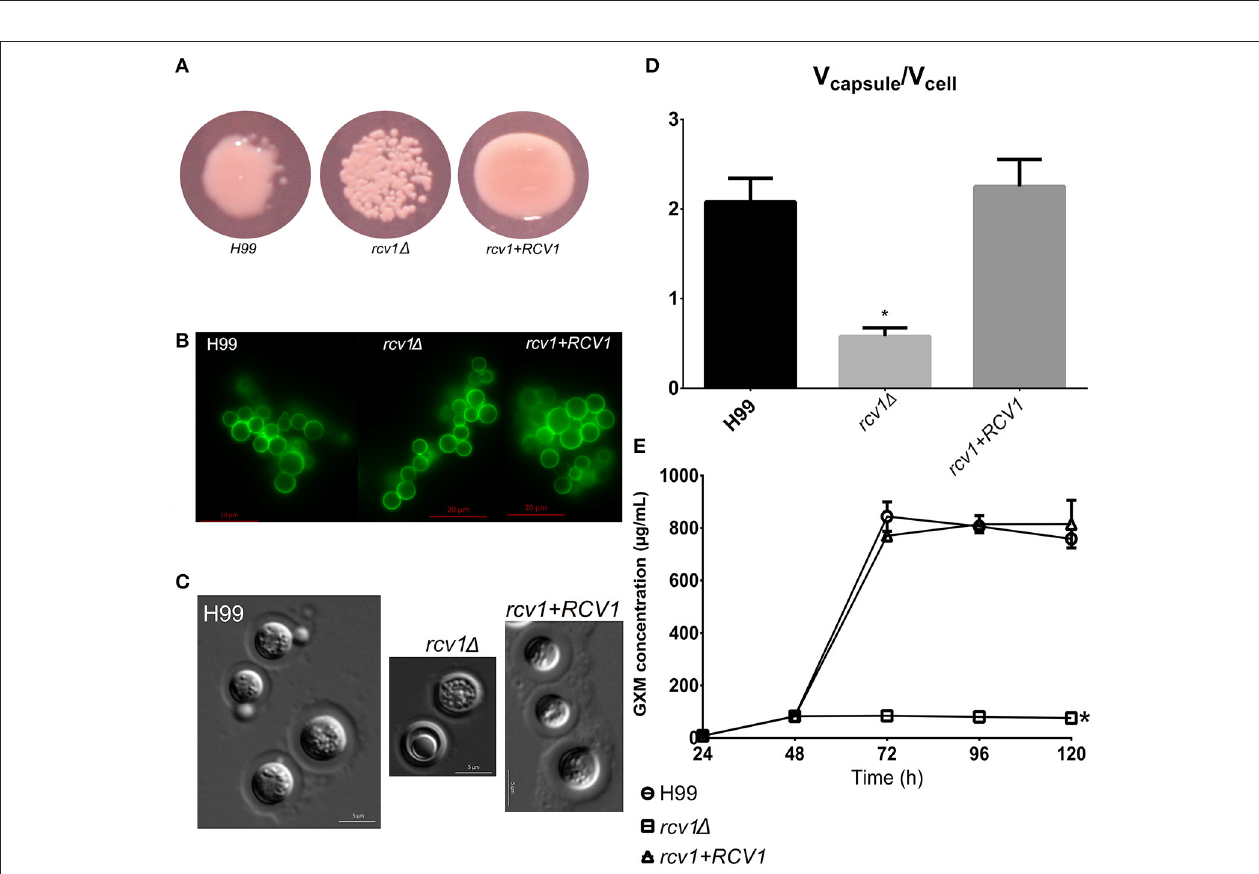
FIGURE 2 | The rcv1 ∆ strain produces capsule, but fails at induction. (A) The mutant colonies appear dry on capsule-inducing solid medium at 37 ◦ C. DMEM-MOPS, 72h. (B) GXM detection by the 2D10 mAb. The clumping is an artifact caused by the antibody, an IgM. Fluorescence. Sabouraud/MOPS, 24h, 37 ◦ C. (C) Percoll observation of the capsule. The mutant has a thin, but visible capsule. DMEM-MOPS, 120h. (D) Comparison of the mean ratios of capsule and cell volumes for cells of each strain (50 per group). DMEM/MOPS, 5 days, 37 ◦ C. * p < 0.0001, Tukey’s post-test, one-way ANOVA. Bars, CI95%. (E) GXM secretion pattern, as determined by ELISA, of the mutant strain on minimal medium relative to H99 and the reconstituted strains. This plot is representative of two experiments, each one done in duplicate. Means with SDs. * p < 0.05, Dunnett’s multiple comparisons test, two-way